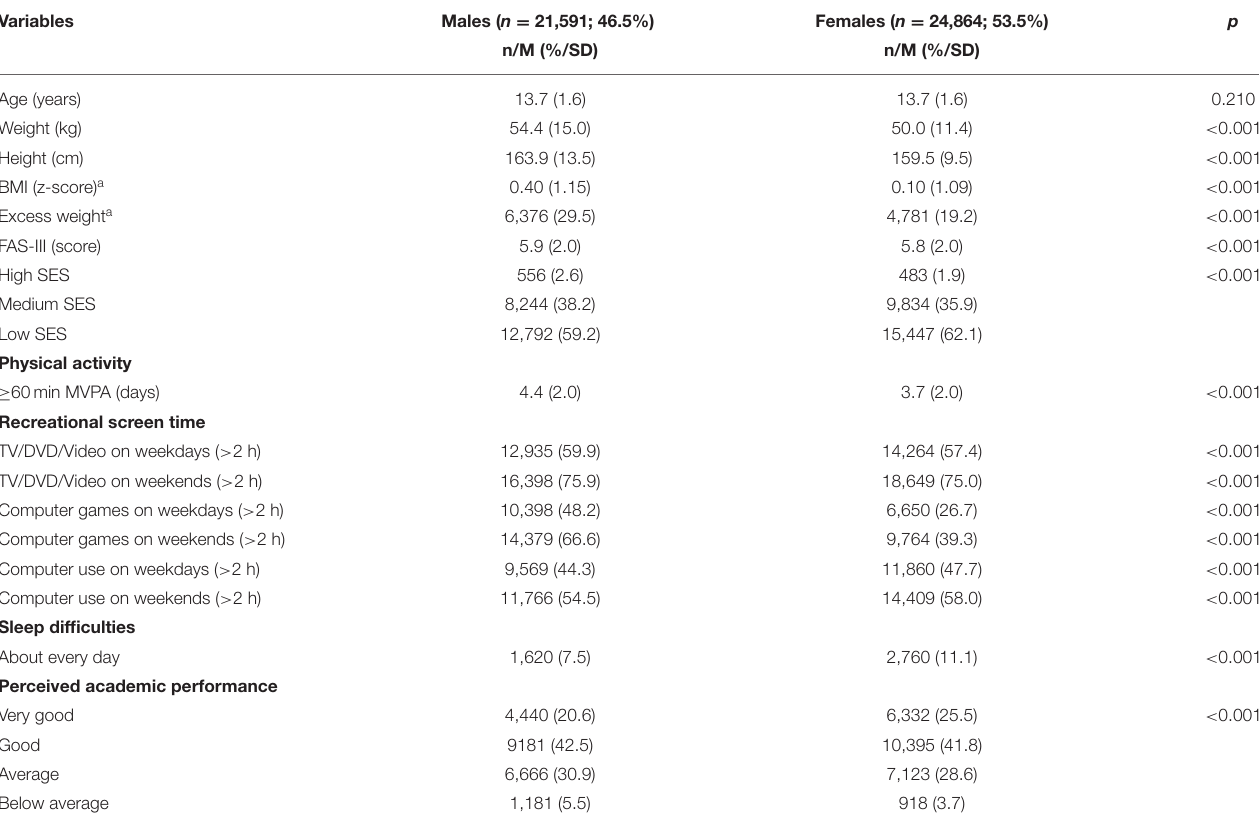
TABLE 1 | Characteristics of the study participants ( N = 46,455).